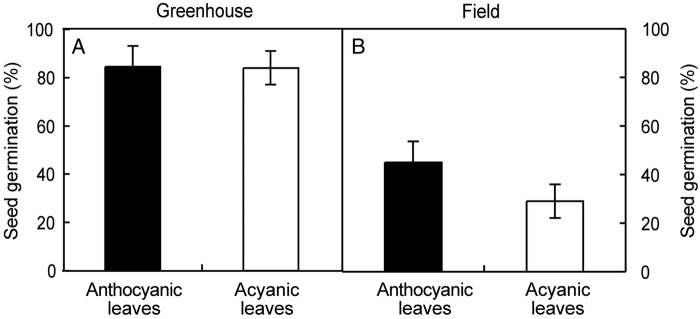
Effect of light filtering by anthocyanic leaves of S. hirsuta on the germination of lettuce seeds. The experiment was performed twice: under exscinded leaves in greenhouse conditions (A) or under living plants in natural conditions in the field (B). Bars represent the mean ± SE (n ≥ 12). No significant differences were found between anthocyanic and acyanic leaves in the number of seeds germinated underneath in any of the two experiments (P > 0.05). Details of the ANOVA analysis for (A): df = 1, mean2 = 2.186, F = 0.011, P = 0.917; for (B): df = 1, mean2 = 1943.29, F = 2.0 and P = 0.167.